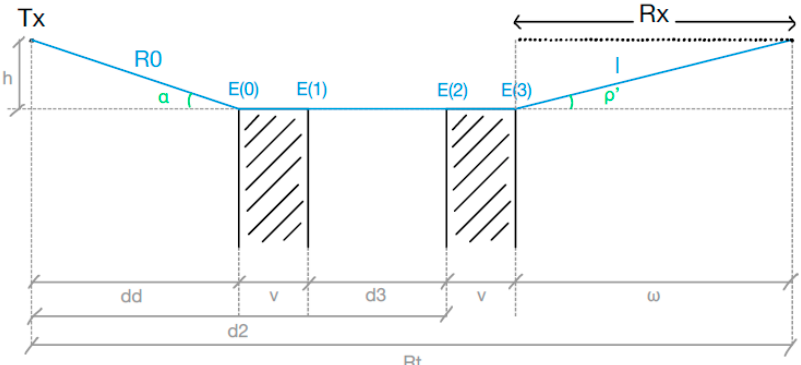
Figure 12. Quadruple diffraction (Edif_q) of the considered LOS scenario.